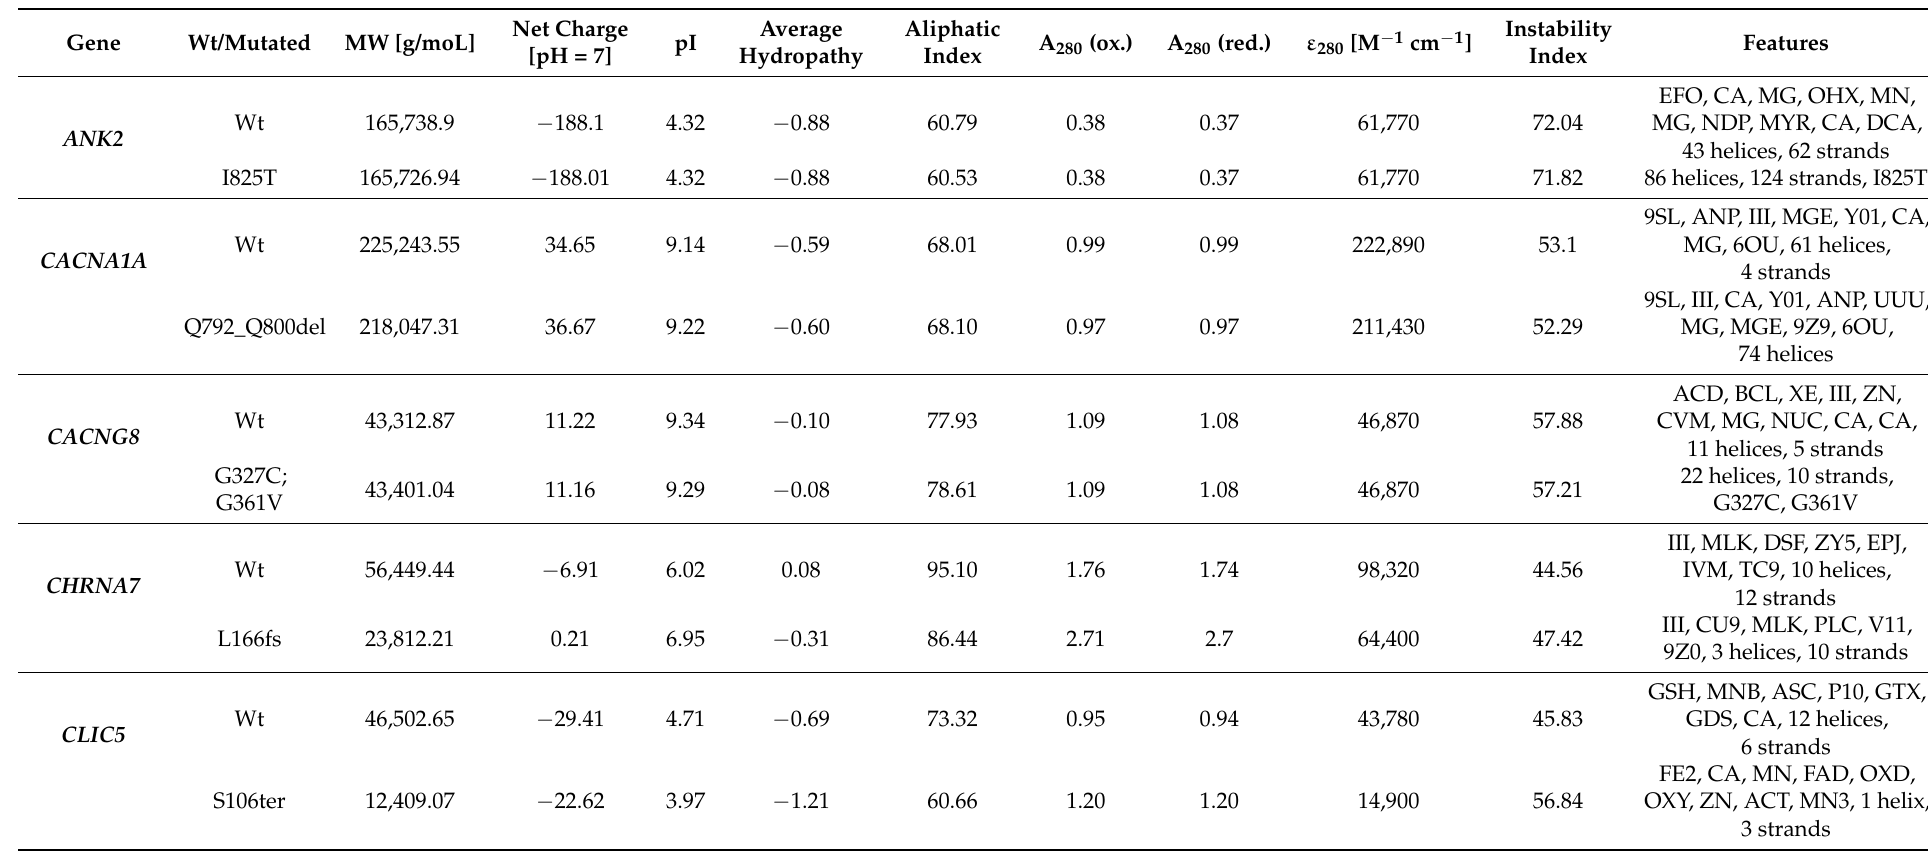
Table 4. Biochemical and physical change prediction between wild-type and mutated ion channel-related proteins. Analyses of biochemical and physical parameters by Protean 3D showed a global alteration of such parameters throughout all investigated proteins, reaching the highest instability in mutated CHRNA7 and